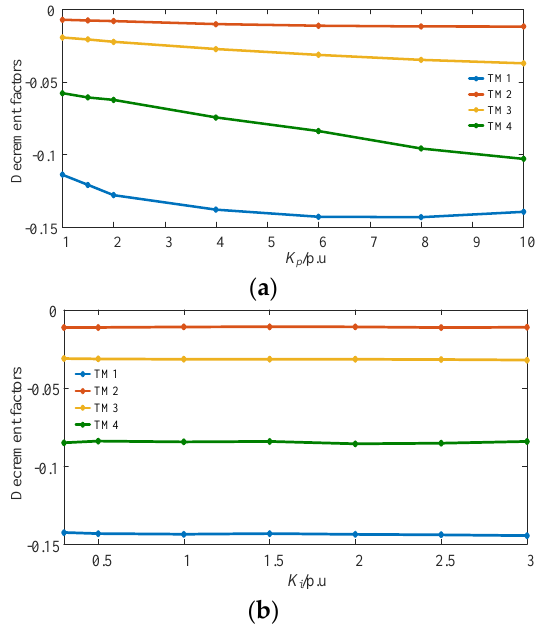
Figure 9. Damping coefficient for each torsional mode of SG under different rotor converter current inner loops: ( a ) different K p ; ( b ) different integral coefficient of the current inner loop ( K i ).